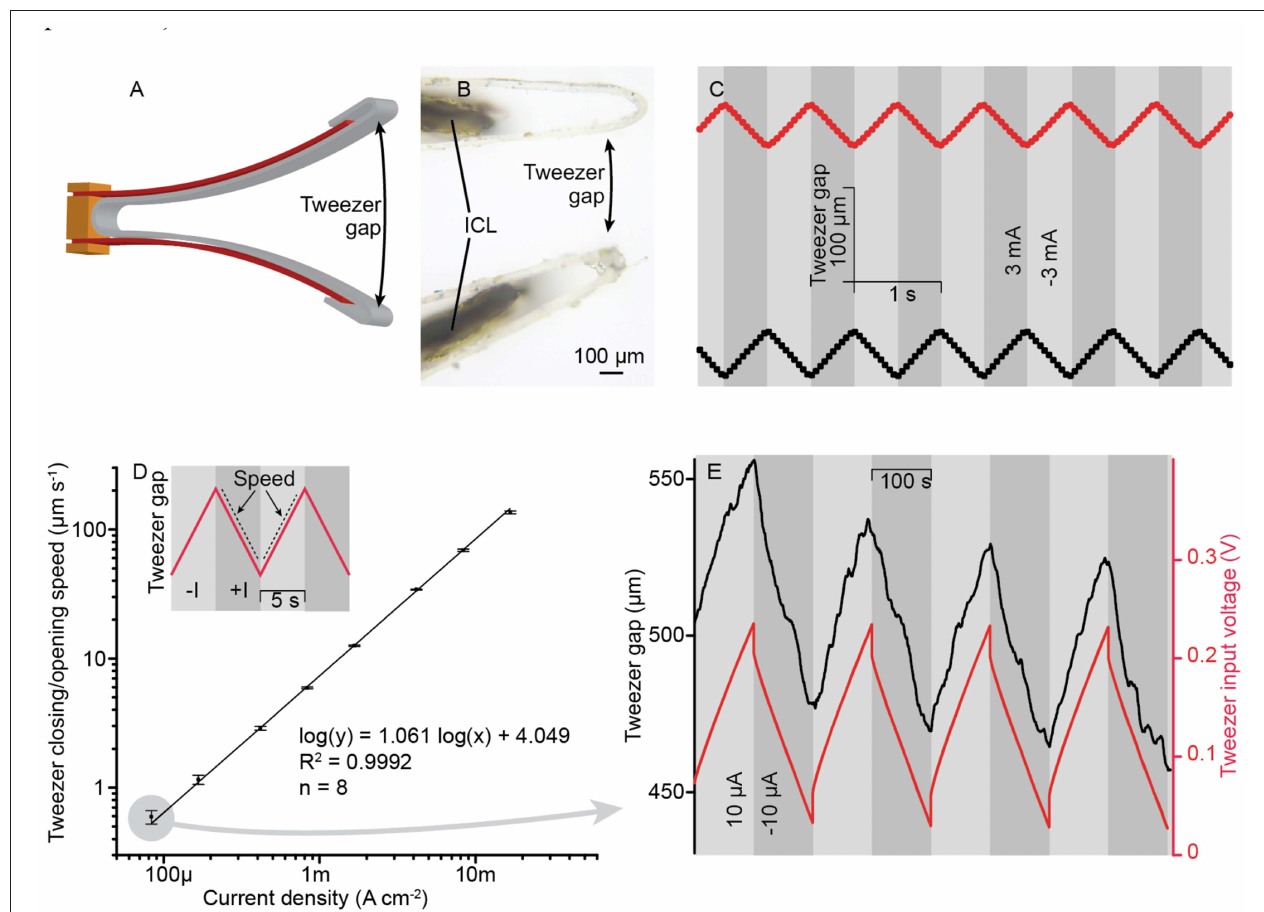
FIGURE 7 | (A) Tweezer gap used as the performance metric for the electroactive tweezers. (B) Microscope image of the tweezer arm tips showing the grips as contact points. (C) The position of tweezer arm tips upon applying a 1-Hz square wave at ± 3mA amplitude. (D) The tweezer closing/opening speed in an unobstructed mode at a range of current densities. (E) The typical response curve of the electroactive tweezers upon applying an extremely small current, ± 10 µ A.